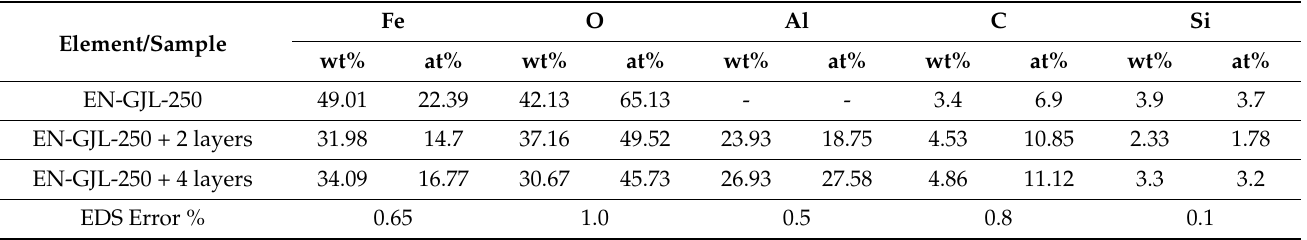
Table 3. Chemical composition of the experimental materials after the electro-corrosion